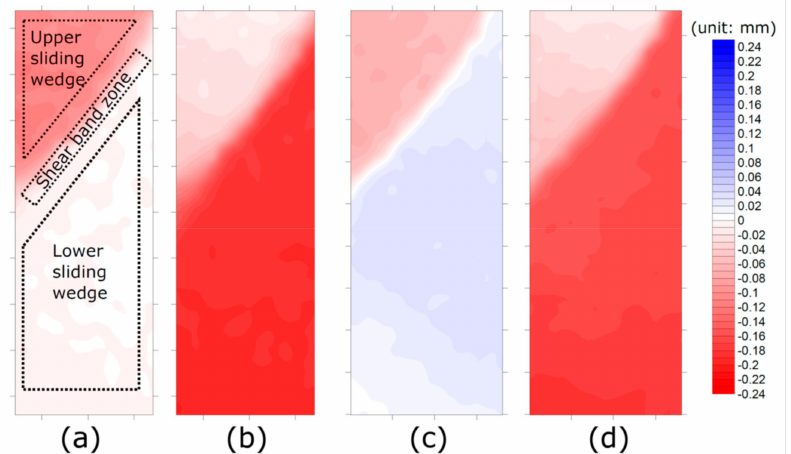
Figure 10. Displacement contours for the softening stage of the stress–strain behavior (2.9–3.15%